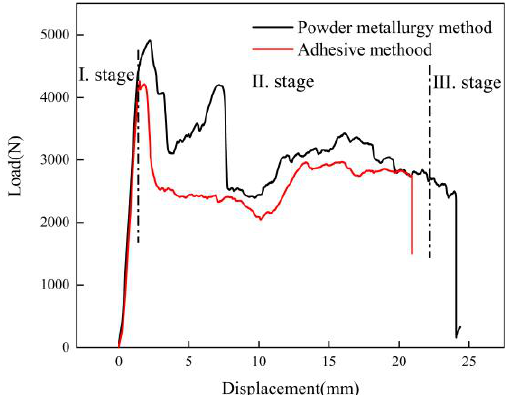
Figure 5. Load-displacement curves of an AFS made by different preparation methods.